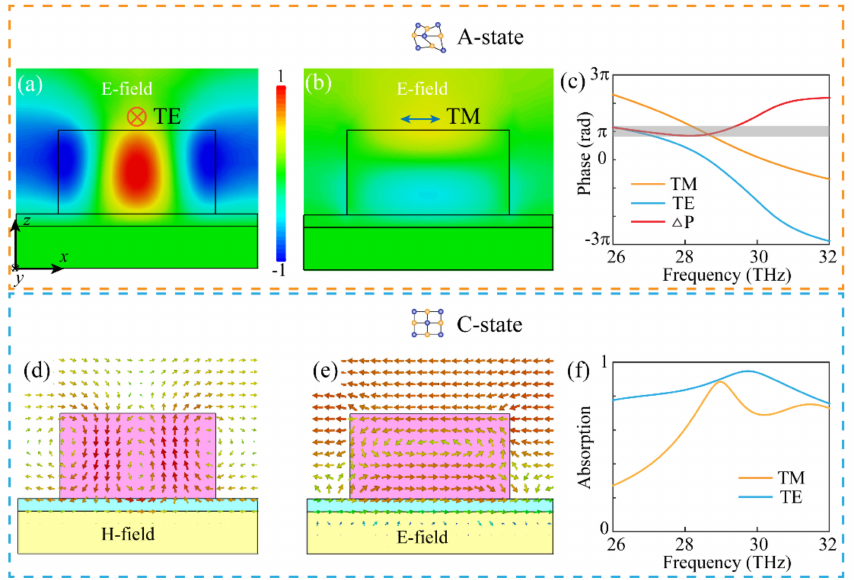
Figure 3. Simulated results under a linearly polarized incidence at 29 THz. ( a , b ) Simulated normal- ized electric field distributions under TE and TM polarized incidence in A-state. ( c ) Relative phase differences between TE and TM polarizations. ( d , e ) Simulated energy flows of magnetic ( d ), and elec- tric ( e ) fields under a TE and TM polarized incidence in C-state. ( f ) Absorption performance for TE and TM incidence. The insets in ( a , b ) define the polarization direction of the TE and TM